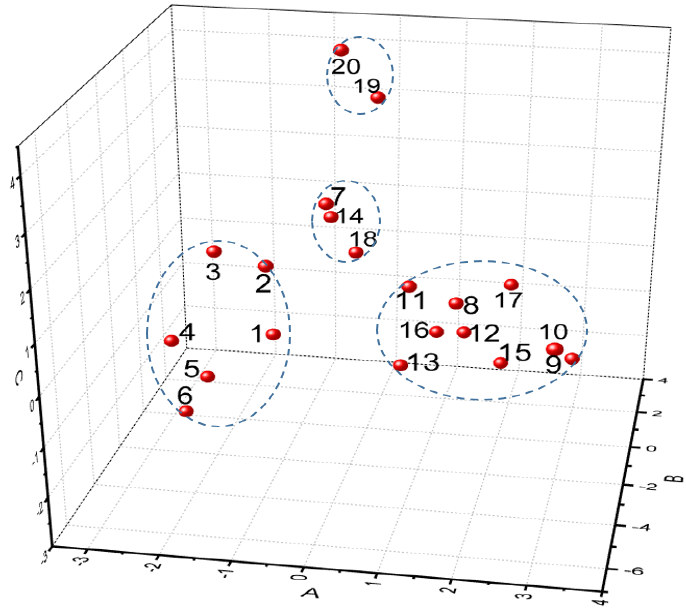
Figure 9. Three-dimensional distribution map of 20 turmeric samples.